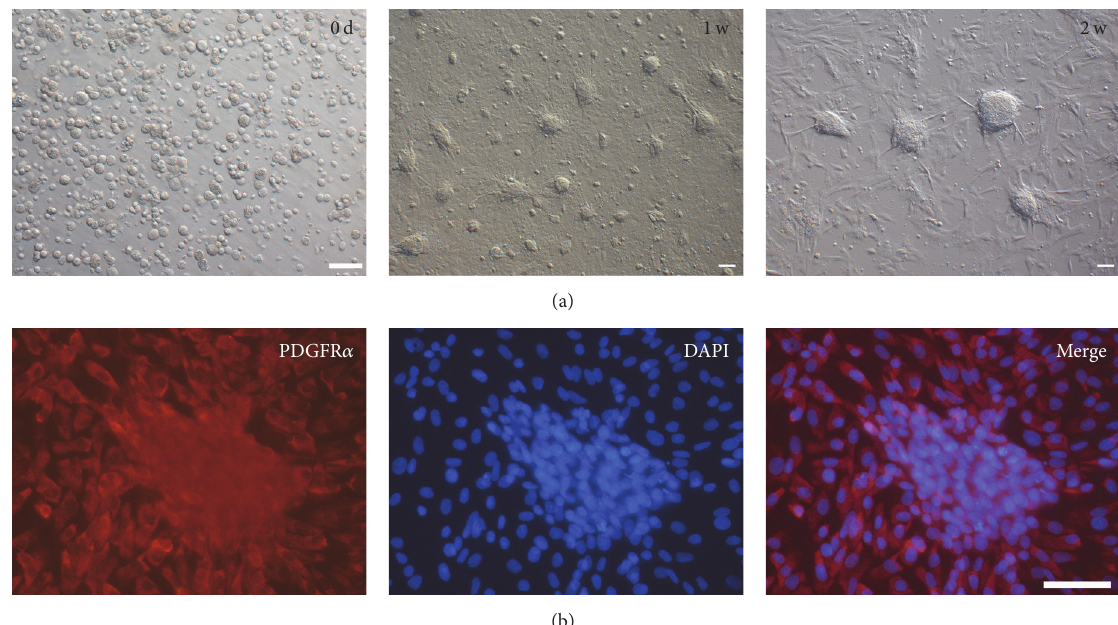
Figure 3: Morphology development and PDGFR 𝛼 immunofluorescence analysis of porcine SLCs cultured in pTF medium (bar = 50 𝜇 m). (a) Morphology development of porcine SLCs cultured 0 d, 1 w, and 2w in pTF medium. (b) PDGFR 𝛼 immunofluorescence of porcine SLCs cultured in pTF medium for 2 w.